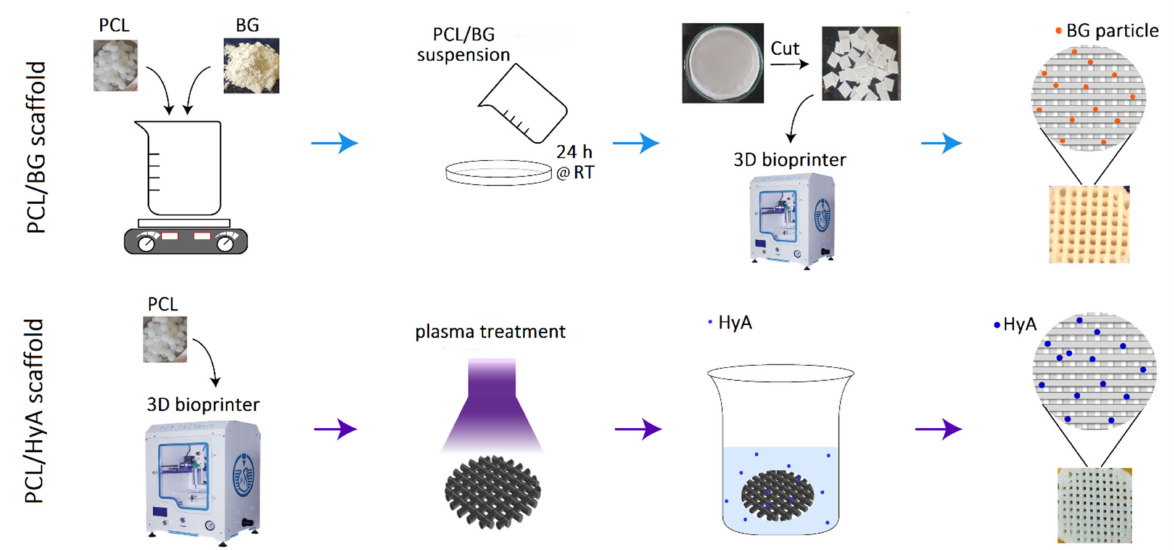
Figure 1. Schematic diagram of 3D-printed PCL/BG and PCL/HyA scaffold fabrication as artificial matrices for dentin and pulp tissue engineering, respectively. Abbreviations used in this Figure are as follows: PCL: polycaprolactone, BG: 45S5 bioactive glass, HyA: hyaluronic acid, h: hour, RT: room